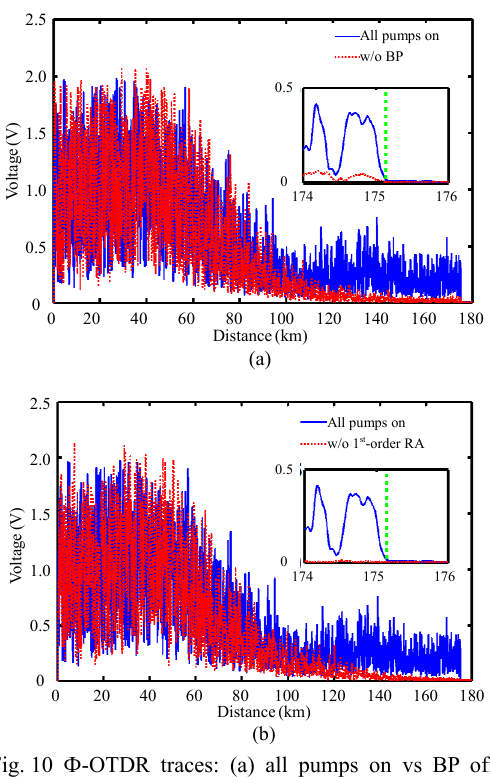
Fig. 10 Ф -OTDR traces: (a) all pumps on vs BP off and (b) all pumps on vs 1 455 nm semiconductor RP off.